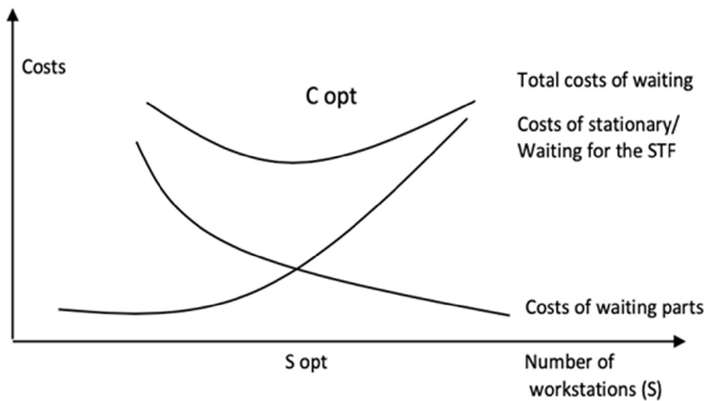
Figure 1. Value as optimal based on the existence of contradictory tendencies.